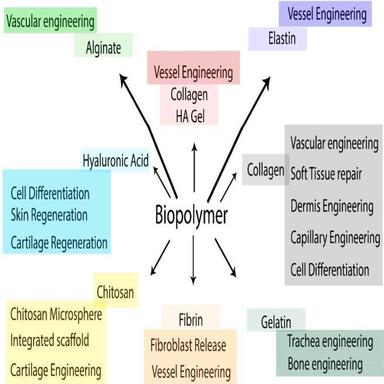
Role of different Biopolymer composites as scaffolds for different organs and in Tissue engineering.